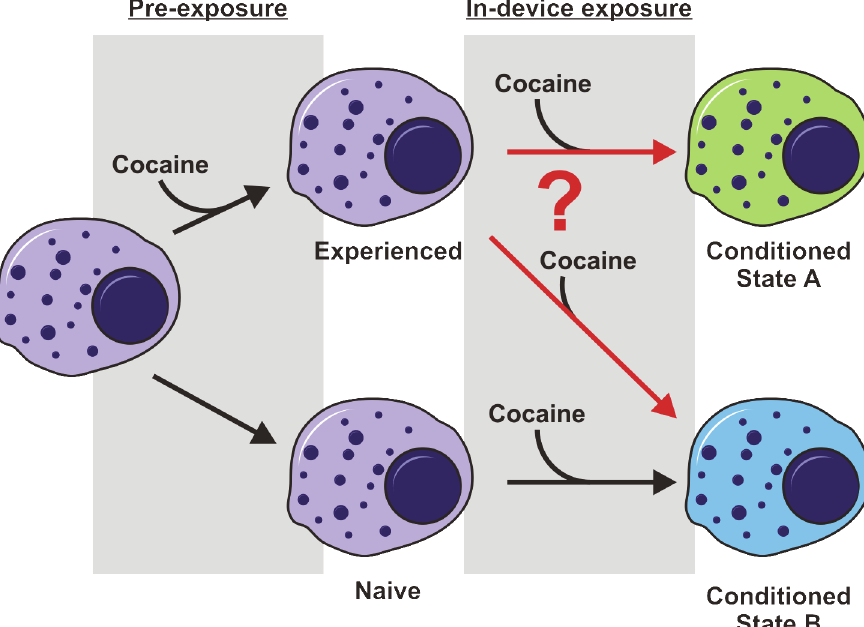
Fig 1. Experimental scheme showing potential cell fates. Upon exposure to cocaine in a microfluidic bioreactor, na ï ve and cocaine-experienced cells present different exometabolomic profiles, demonstrated here as color change. Our experiments were designed to determine whether cocaine-experienced cells went to a conditioned state A that was different from state B reached by na ï ve cells.